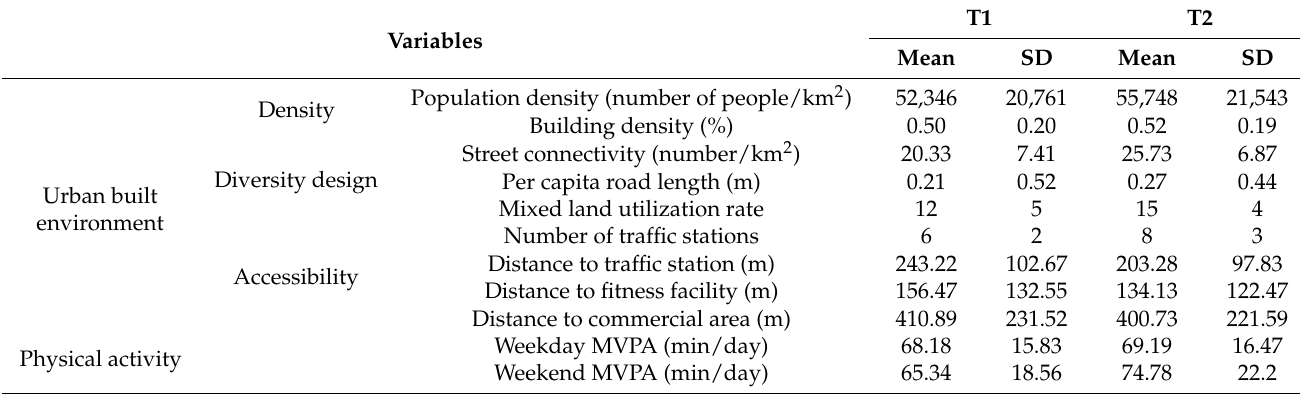
Table 2. Descriptive statistics of